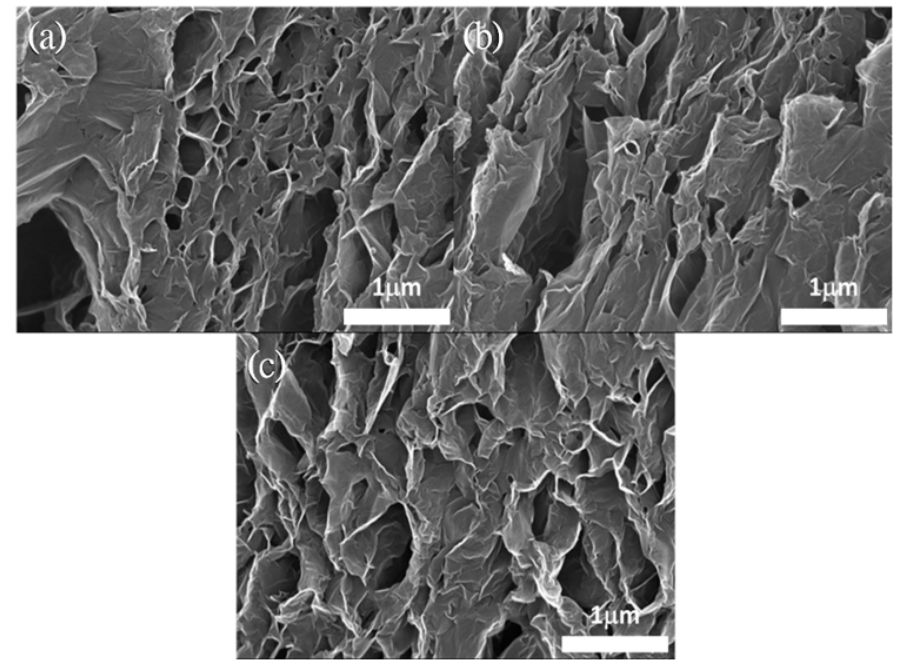
Figure 8. SEM morphology of ( a ) GN300, ( b ) GN700 and ( c ) GN1100.